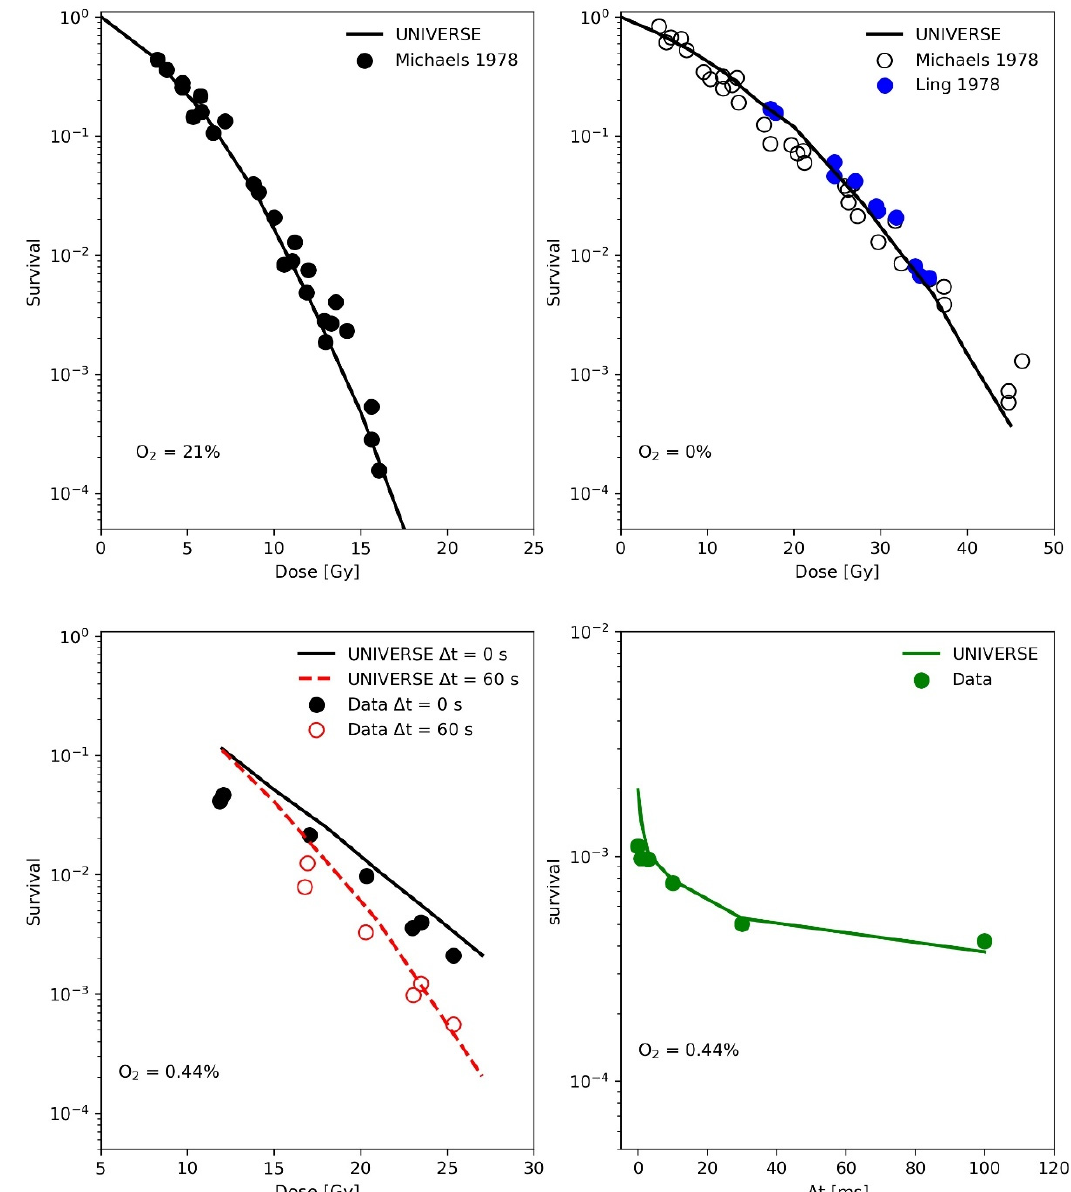
Figure 2. ( Upper-left panel ): Measured (filled circles) and simulated (line) CHO cell survival as function of dose under normoxic conditions with a 3 ns electron pulse. Data taken from [17]. ( Upper -right panel ): Measured (filled circles) and predicted (line) CHO cell survival as function of dose under anoxic conditions with a 3 ns electron pulse. Data provided by the same group but presented in different publications [15,17] are shown as reported in the legend. ( Lower-left panel ): Measured (filled circles) and simulated (lines) surviving fraction of CHO cells irradiated by two 3 ns pulses (first pulse with a fixed dose of 12 Gy, second pulse with variable dose) separated in time by inter- pulse time ( Δ t) of 0 s or 60 s as reported in the legend. The cells were equilibrated in a 0.44% O 2 atmosphere in the irradiation chamber. ( Lower-right panel ): Measured (filled circles) and predicted (line) surviving fraction of CHO cells irradiated with two electron pulses separated by various inter- pulse time Δ t. Again, the cells were equilibrated in the irradiation chamber with an atmosphere containing 0.44% O 2. Data taken from [15]. 2.2. Resulting O 2 Depletion in UNIVERSE vs. Experimental Data in the Literature The preceding analysis implied a reduction of the oxygen depletion rate constant g by a factor of 0.7 in comparison to our previous implementation [12], resulting in a value